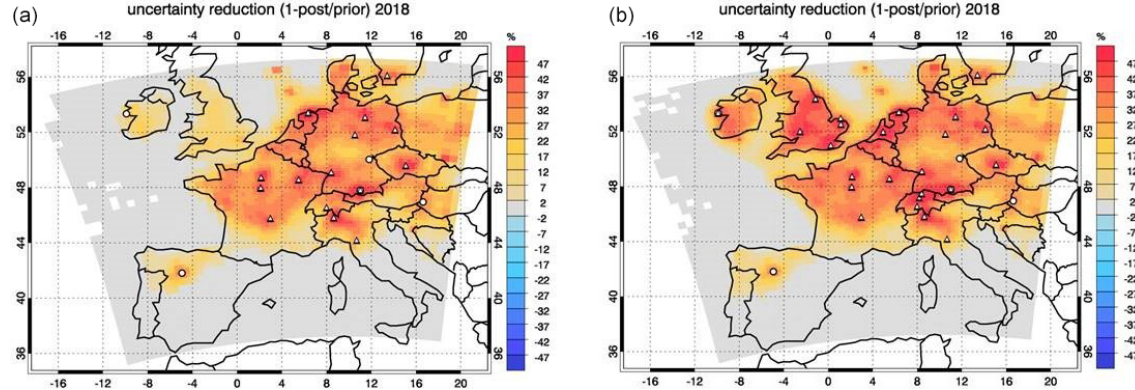
Figure 7. FLExKF uncertainty reduction maps computed as (1 − (cid:49) post /(cid:49) prior) for the same year, 2018, but with two different sets of observation stations (white